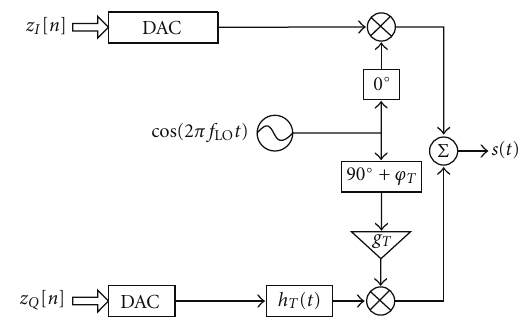
Figure 1: Block diagram of Frequency-selective transmitter I/Q imbalance